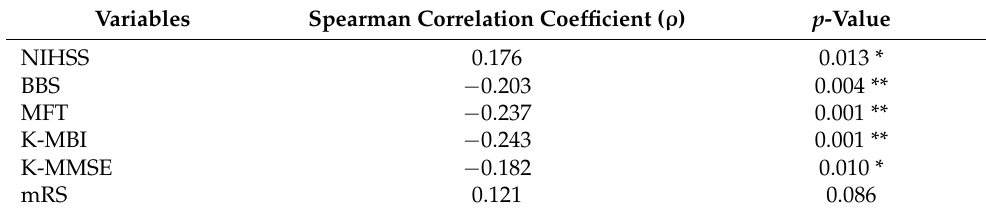
Table 4. Correlations of NLR with stroke severity and functional outcomes.